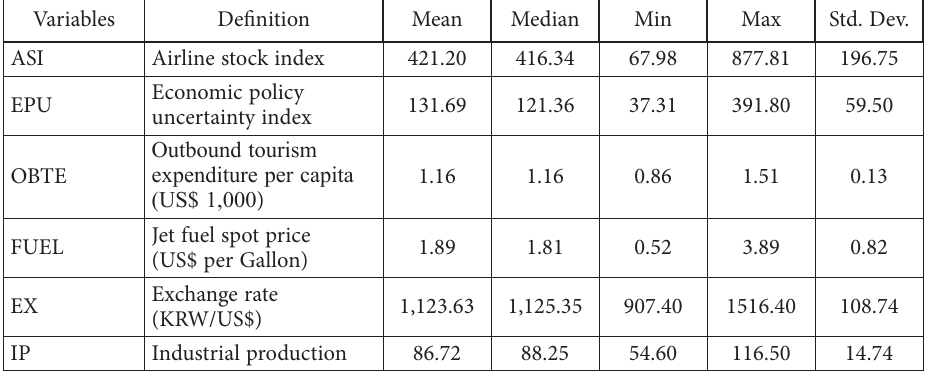
Table 1. Summary statistics ( N =